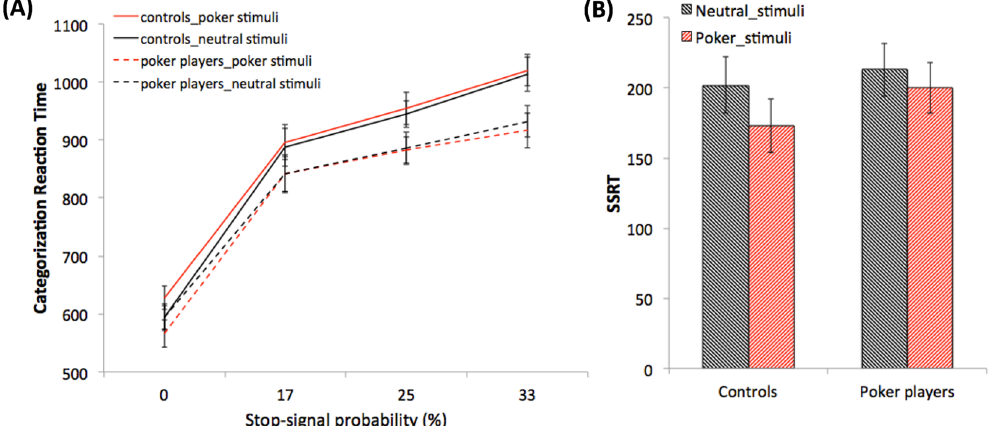
Figure 1. ( A ) Proactive inhibition: effect of stop-signal probability contexts (0% = green, 17% = yellow, 25% = orange, 33% = red) on go_signal response time for poker (in red) and neutral (in black) stimuli in the control and the poker player groups; ( B ) Reactive inhibition: stop-signal reaction time (SSRT) for poker (in red) and neutral (in black) stimuli in the control and the poker player groups. All errors bars indicate 95% confidence